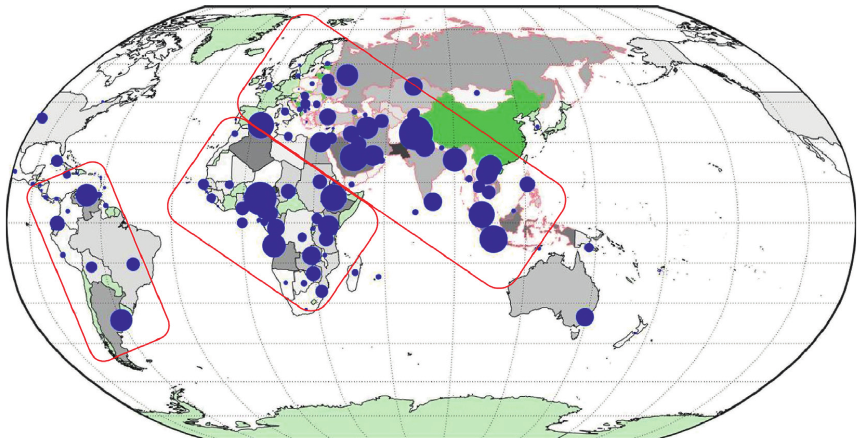
Figure 13: Spatial distribution of COCP (2005–2017) (No.